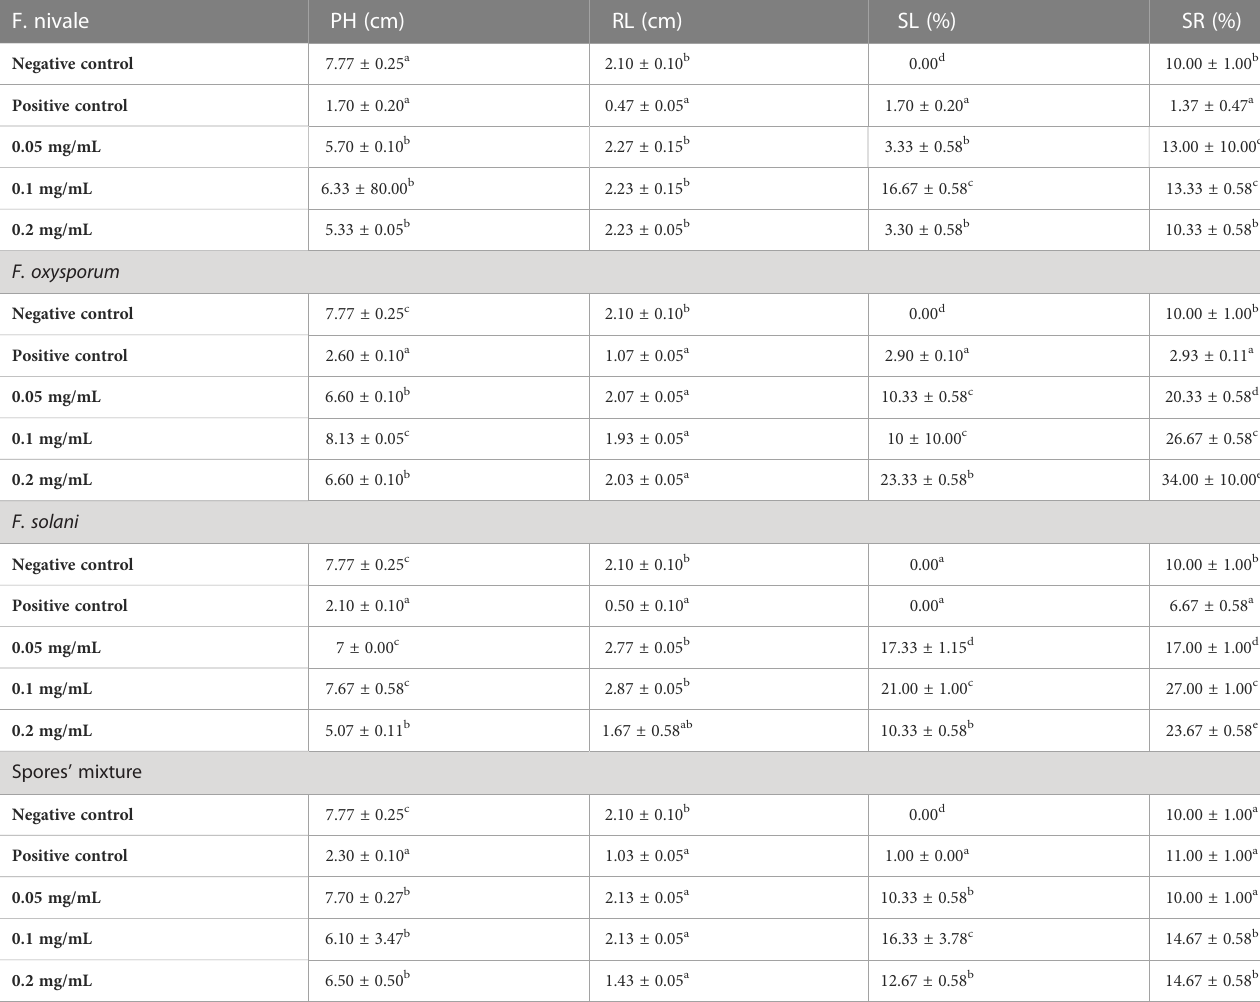
TABLE 3 The effect of carvacrol treatment on the coleoptile growth and on rhizogenesis of the ryegrass in vitro . F. nivale